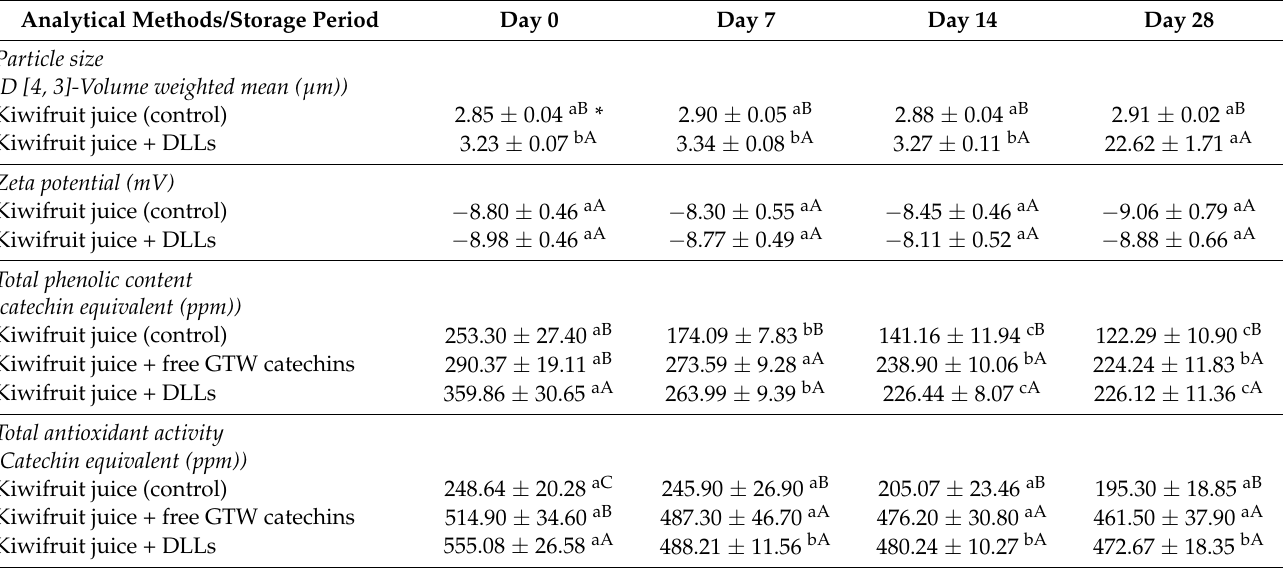
Table 1. The particle size (D [4, 3]-Volume weighted mean ( µ m)), zeta potential (mV), total phenolic content (ppm), and total antioxidant activity (ppm) of kiwifruit juice containing the double-layer liposomes (DLLs) during the 28 days of storage at 4 ◦